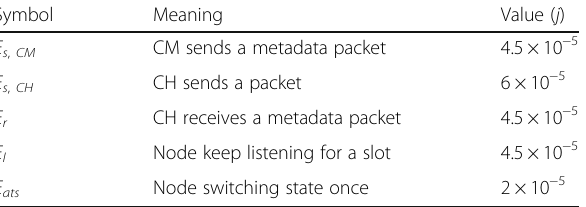
Table 1 Energy consumption for different